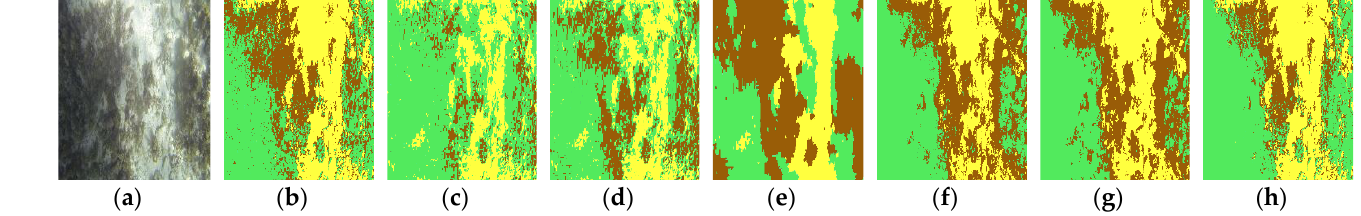
Figure 14. Validation tests of the proposed segmentation algorithms using low illuminated and high contrast brown algae image (6) from Figure 10 as example of three categories: ( a ) original image; ( b ) ground truth image; ( c ) KM result; ( d ) KMAc result; ( e ) FFCr result; ( f ) FRCr result; ( g ) OSCr result; ( h ) KMCr result. 3 – 6. Brown: brown algae, green: algae, and yellow: sediments.